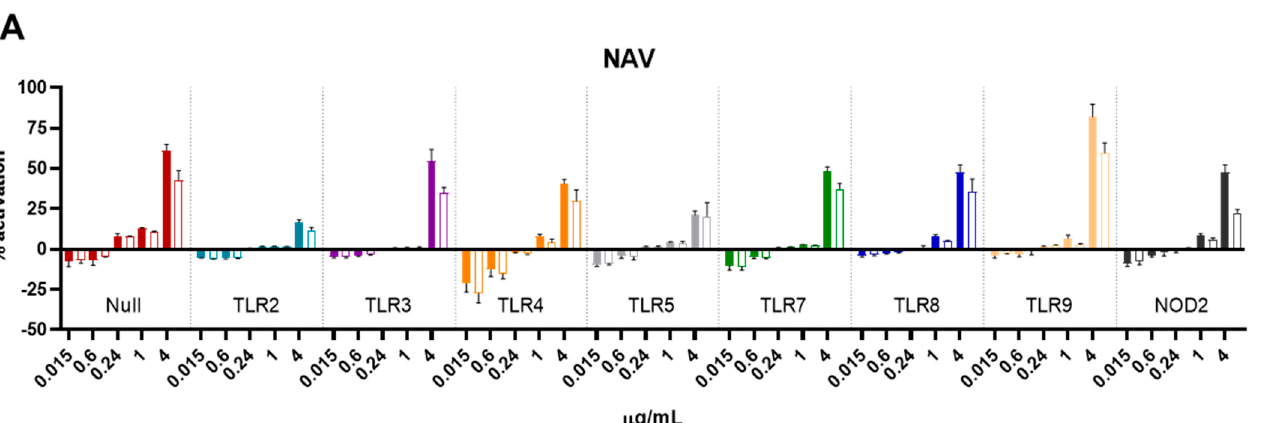
Figure 5. Activation of HEK Blue reporter cells by I-TBEV and live TBEV. ( A ) HEK Blue cells were stimulated with the indicated amounts of I-TBEV for 48 h at different concentrations. Subsequently, supernatants were added to the detection medium for assessment of NF- κ B-induced production of the reporter protein. The stimulation of the cells is presented as a percentage of activation relative to the activation achieved with 2.5 μ g/mL of TNF- α (set as 100%). Filled bars represent the responses to I-TBEV, empty bars responses to the matrix. ( B ) HEK Blue cells were stimulated with live TBEV virus for 48 h at the indicated multiplicity of infection (MOI), and activation was assessed as described above. Levels of significance: ns: p > 0.05; *: p ≤ 0.05; **: p ≤ 0.01 and ***: p ≤ 0.001 (compared to the level of activation in the Null cells stimulated with the same MOI). Results are from 3 replicates. 4. Discussion In this study, we assessed the cellular responses and pathways induced by I-TBEV, the main component of the TBE vaccine, and by the replicating virus in human primary cells and reporter cell lines. Our first aim was to extensively characterize the innate im- mune signature induced by I-TBEV in our human PBMC platform in comparison to un- treated cells, as well as to cells treated with low-quality I-TBEV or live virus. The second aim was to identify the pattern recognition receptors responsible for (I-)TBEV sensing. Addressing the first aim, we found that I-TBEV induced an interferon-dominated immune profile and the upregulation of selected inflammatory genes. The low-quality formulation, HT I-TBEV, triggered a qualitatively similar expression signature; however, it had much lower response magnitudes. While the sequencing results were obtained in cells derived from only one donor, the same expression pattern emerged in the validation of the results with 2 additional donors, and the findings are in line with previous results on selected I-TBEV-induced responses in primary human immune cells from several do- nors [17,33]. Indeed, the induction of IFN responses has been identified as a common early signature for several vaccines [38]. Interestingly, selected genes involved in antigen